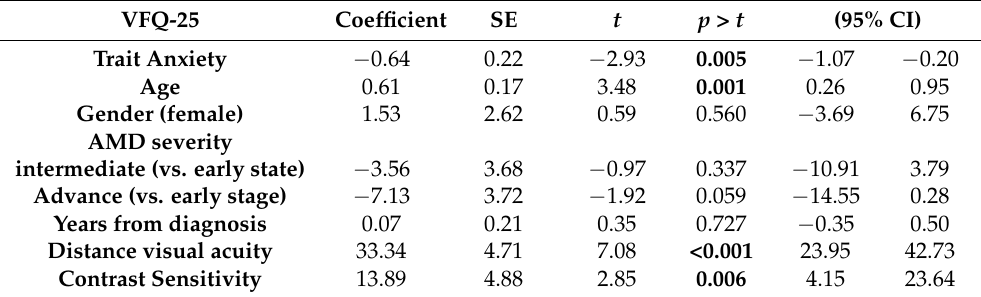
Table 3. Multiple linear regression model that correlates trait anxiety with quality of life. VFQ-25